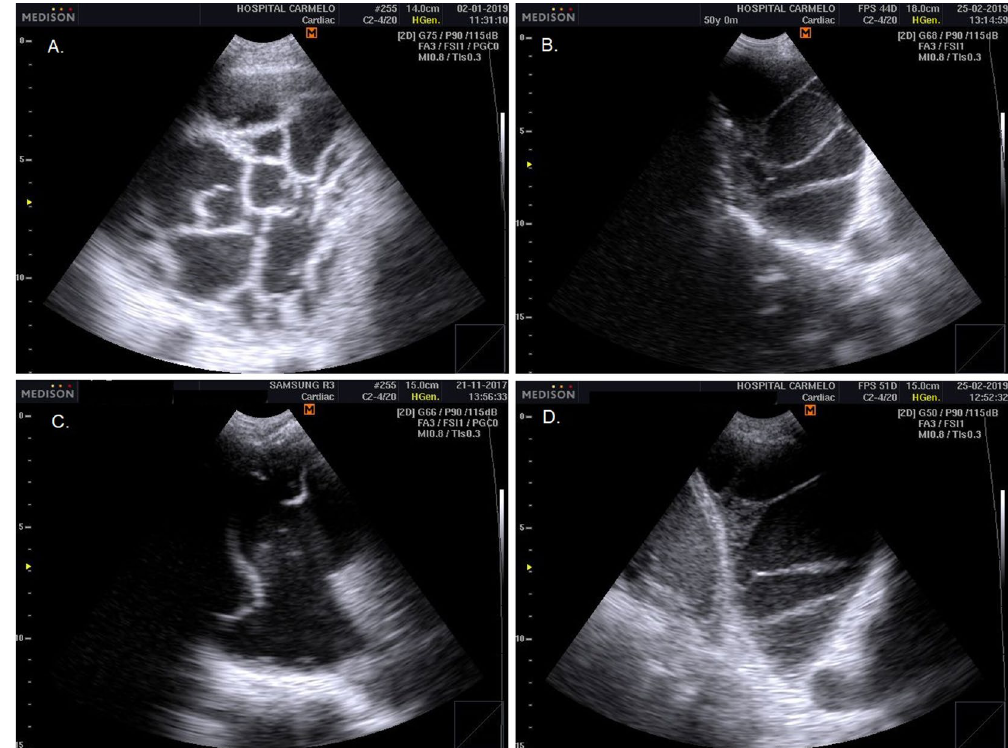
Figure 3. Pleural TB: pleural thickening adjoining a complex pleural effusion with multiple thin septation and fibrinous strands in the pleural space, producing a weblike or branching